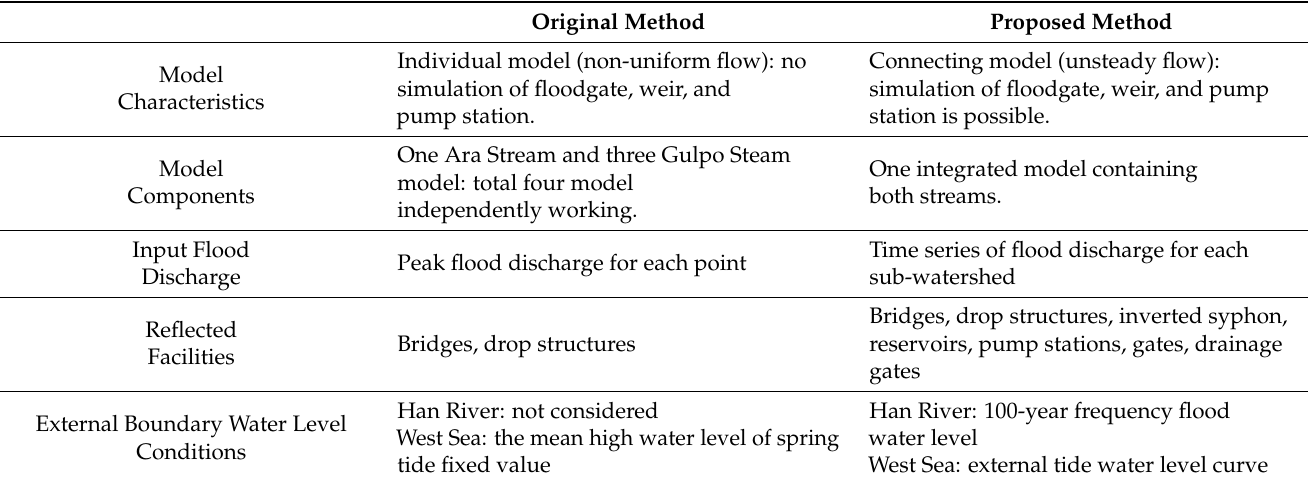
Table 3. Summary Comparison of Original and Proposed